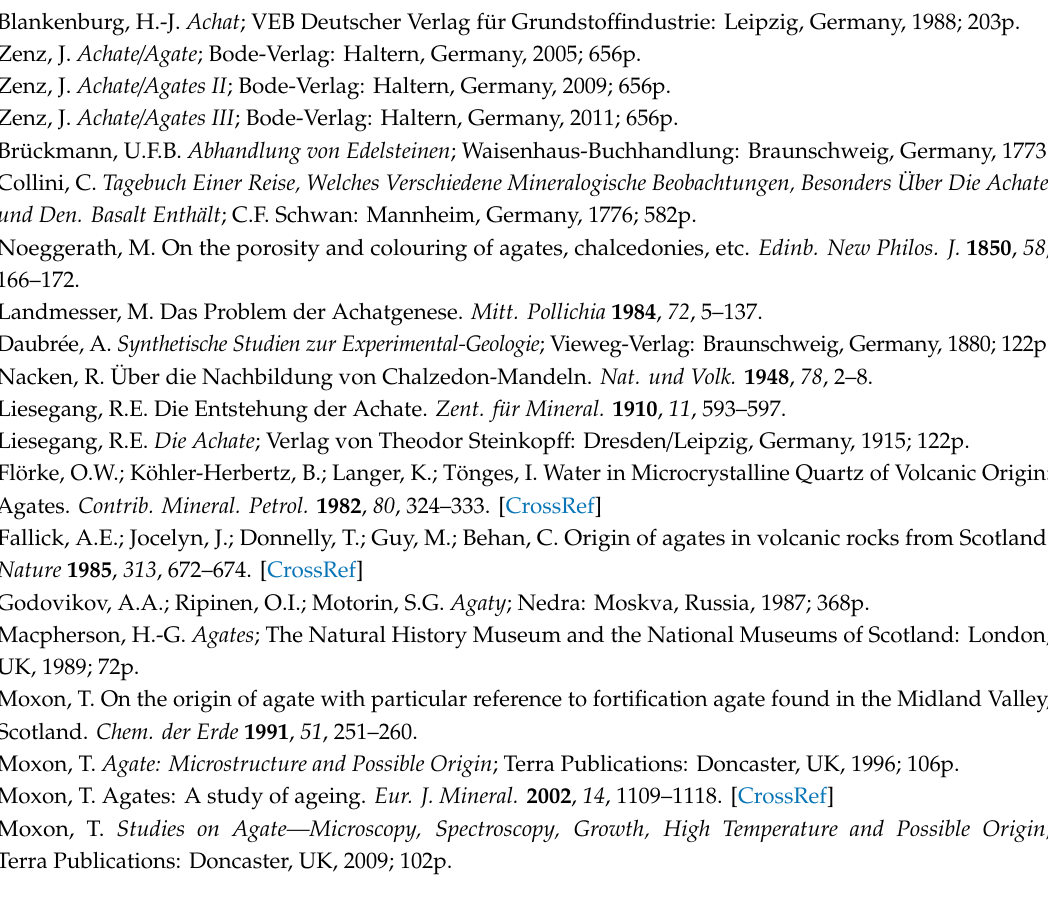
Table S1: Compilation of investigated agate occurrences with references to presented data and relevant published results,